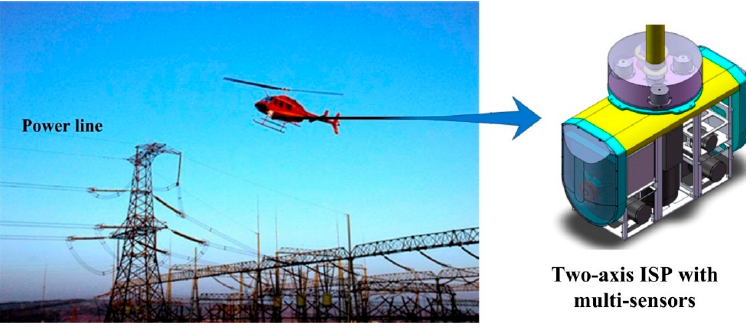
Figure 1. Schematic diagram of an APLI system and the two-axis ISP with multi-sensors.